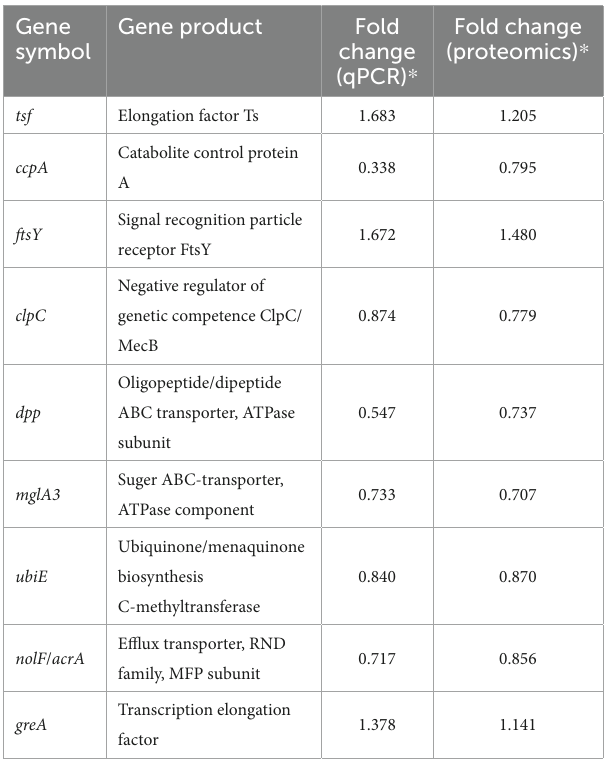
TABLE 1 Transcriptional complementation of the proteomic output by qPCR